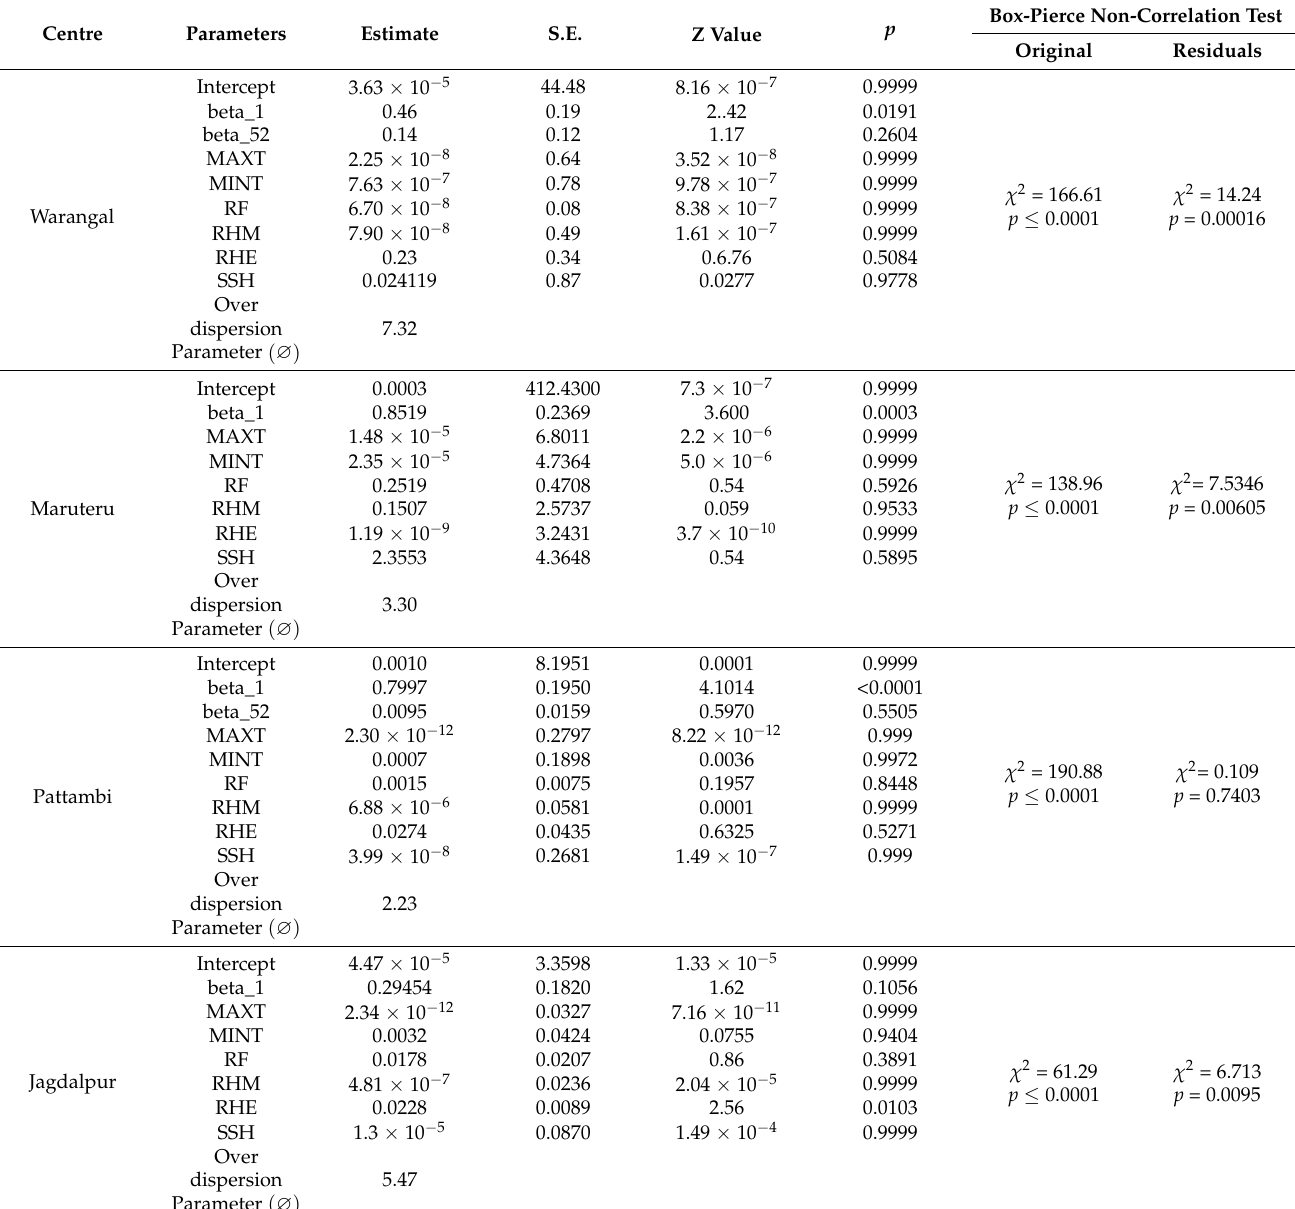
Table 4. Parameter estimation of the INGARCHX model for gall midge populations at study